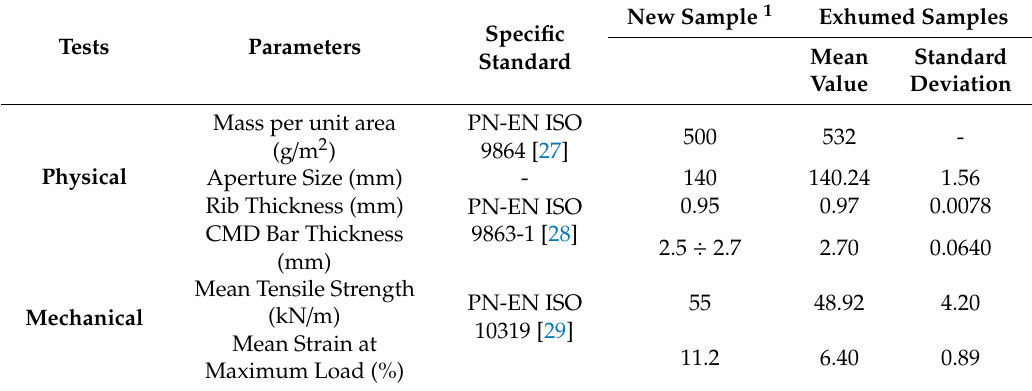
Table 4. Mechanical and physical characteristics of the geogrid determined based on laboratory tests.